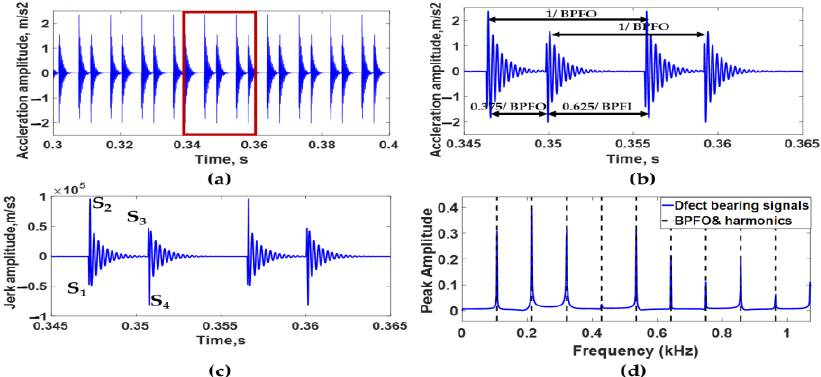
Figure 7. ( a ) Simulated acceleration signal of bearing with double defects (dent and bump) on its outer race at 25 ◦ , ( b ) enlarged simulated acceleration signal between 0.34 s and 0.36 s, ( c ) simulated jerk signal in time domain, and ( d ) envelope spectrum of simulated acceleration signal.